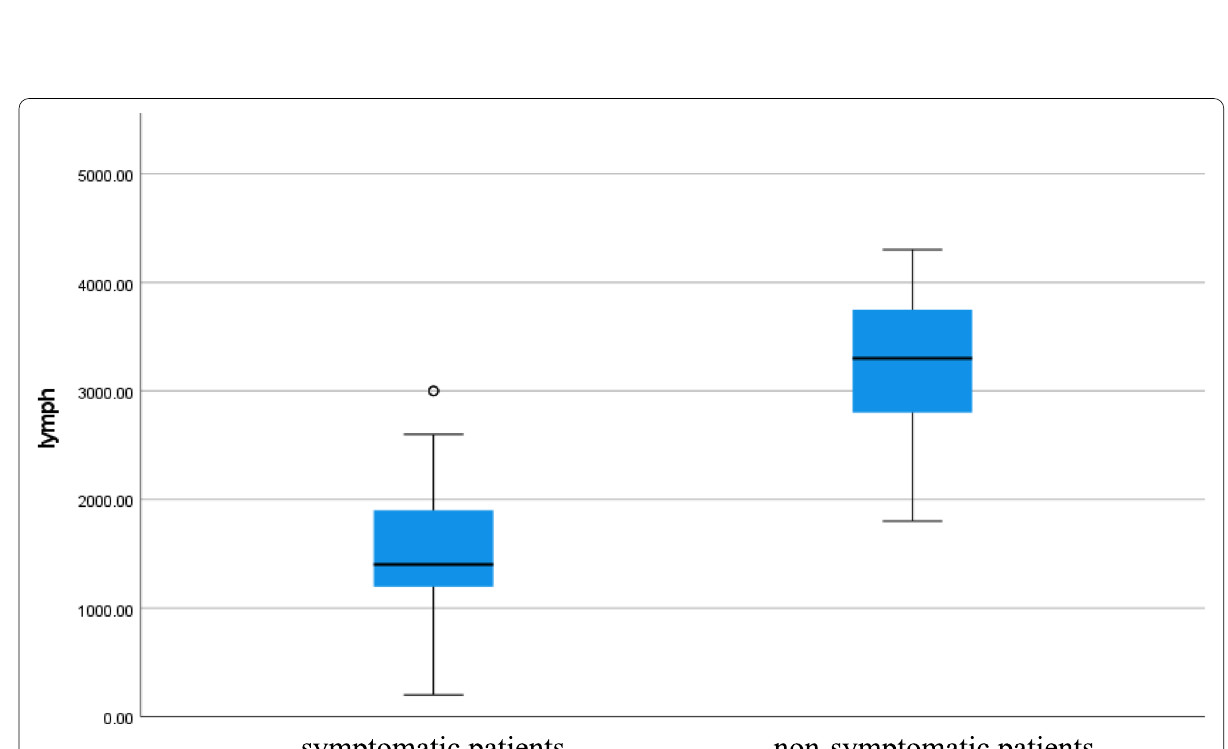
Fig. 4 Lymphocytic count of COVID 19 patients (symptomatic and